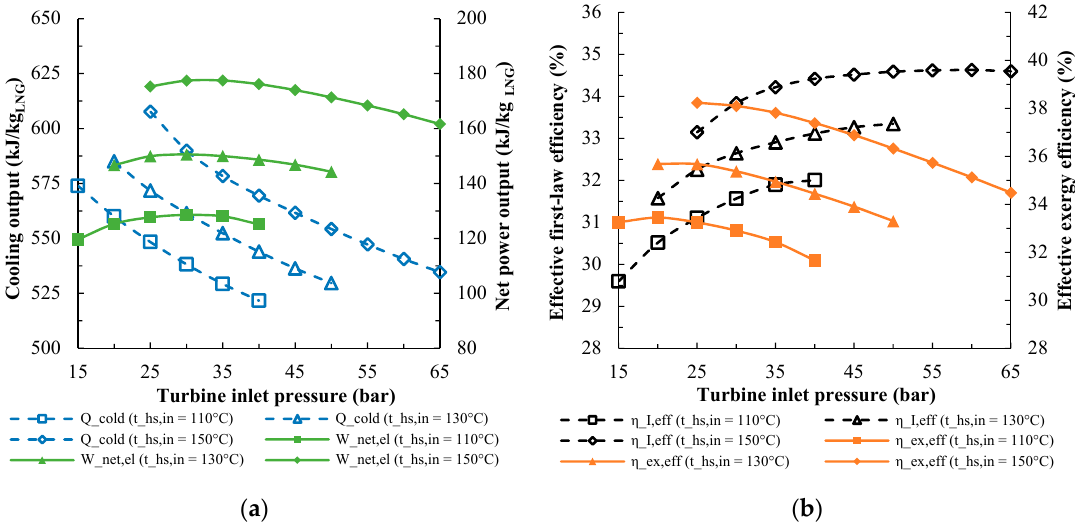
Figure 5. E ff ect of the KC sub-system turbine inlet pressure on poly-generation system performance at di ff erent heat source temperatures ( t 18 = 110 ◦ C, 130 ◦ C, and 150 ◦ C): ( a ) Useful cooling and electrical power outputs; ( b ) Overall e ffi